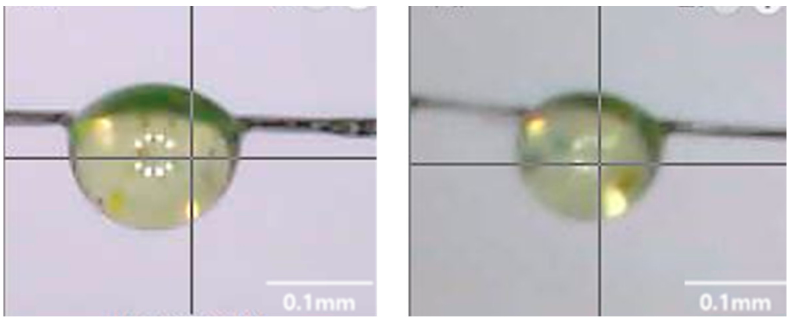
Figure 4. Specimen of microdroplet debonding test.